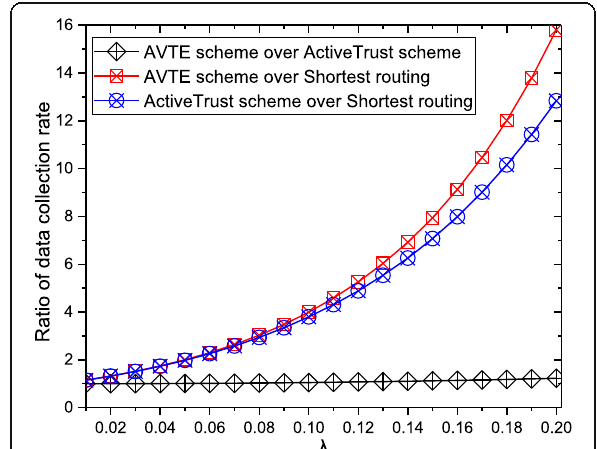
Fig. 15 Ratio of data collection rate with different schemes under different ratio of malicious